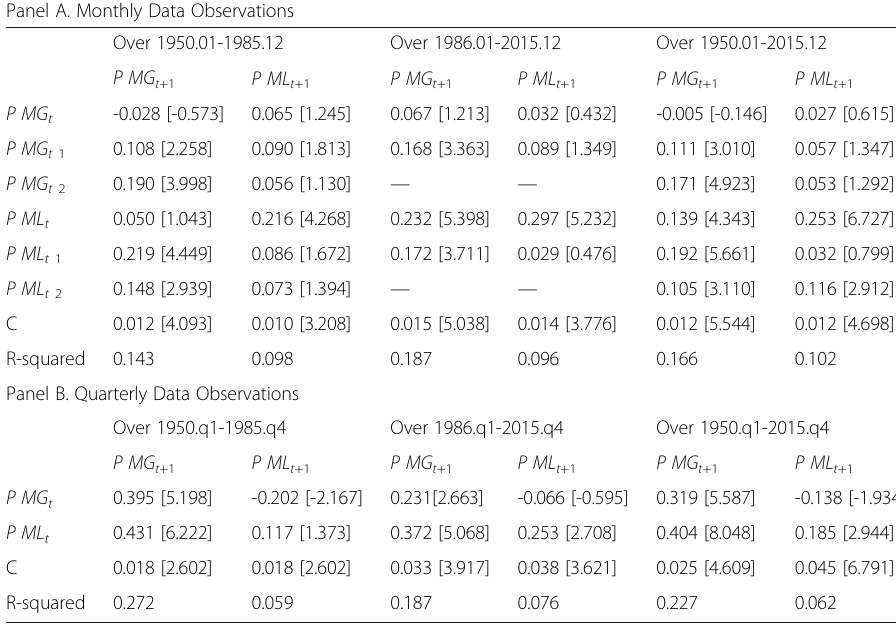
Table 7 Vector AutoRegressive Model Estimation Panel A. Monthly Data